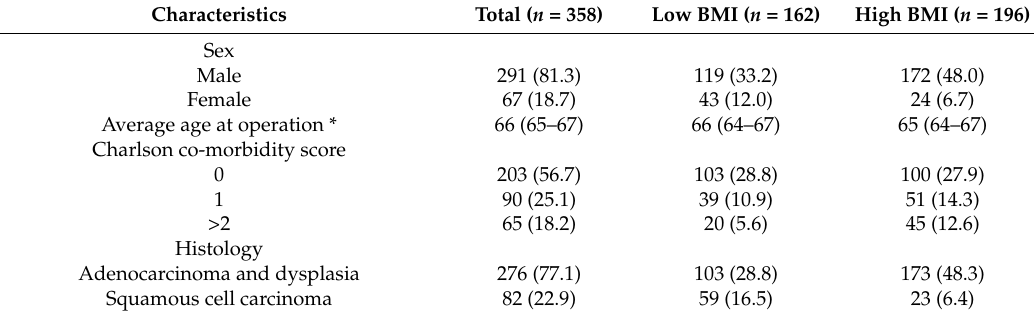
Table 1. Characteristics of patients who underwent surgery for oesophageal cancer in Sweden 2001–2005 and responded to questionnaires at 6 months after the